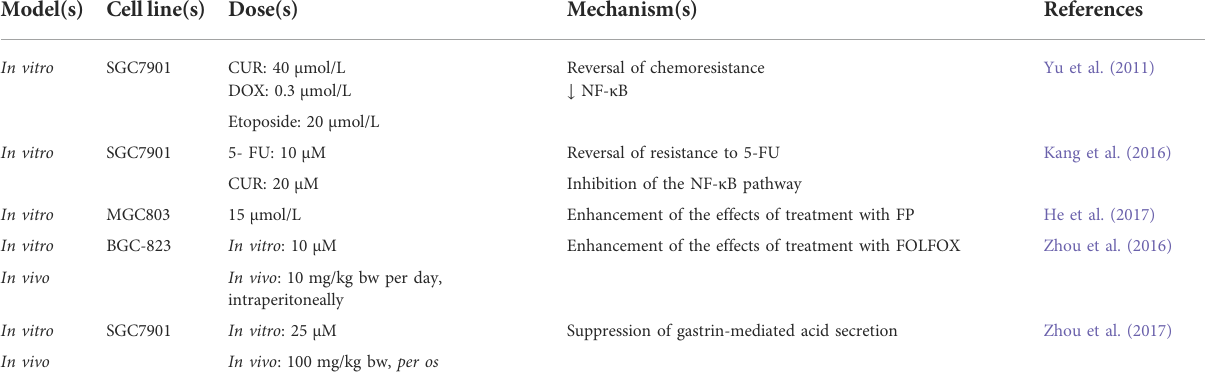
TABLE 1 ( Continued ) Pharmacological mechanism underlying the effects of curcumin on gastric